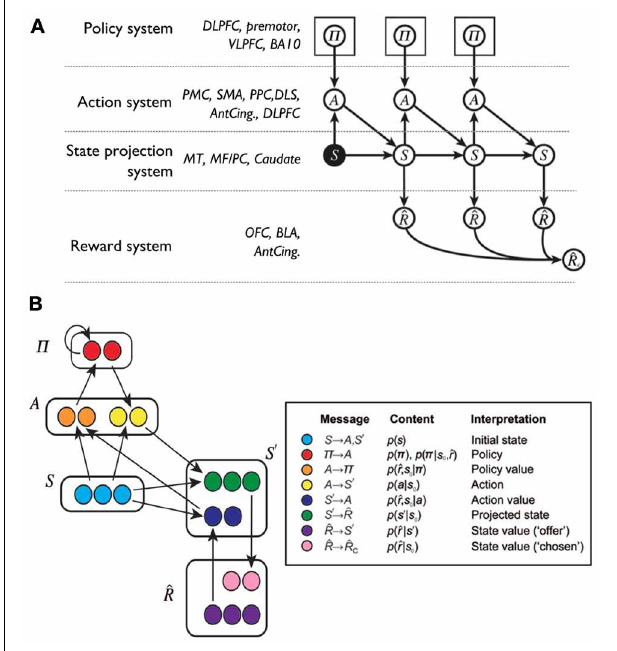
FIGURE 6 | A Bayesian interpretation of goal-directed learning proposed by Solway and Botvinick (2012). (A) Graphical model supporting the probabilistic factorization of a model-based reinforcement learning problem, and hence of goal-directed behavior, with a list of possible biological correspondents. ACC, anterior cingulate cortex; BA, Brodmann area; BLA, basolateral amygdala; dlPFC, dorsolateral prefrontal cortex; DLS, dorsolateral striatum; MF/PC, medial frontal/parietal cortex; MT, medial temporal cortex; PFC, prefrontal cortex; PC, parietal cortex; PMC, premotor cortex; SMA, supplementary motor area; vlPFC, ventrolateral prefrontal cortex. (B) A possible neural implementation of the functional architecture: based on (A) the reader might attempt to link neural areas to the components of the architecture. Adapted and reprinted with permission (Solway and Botvinick,